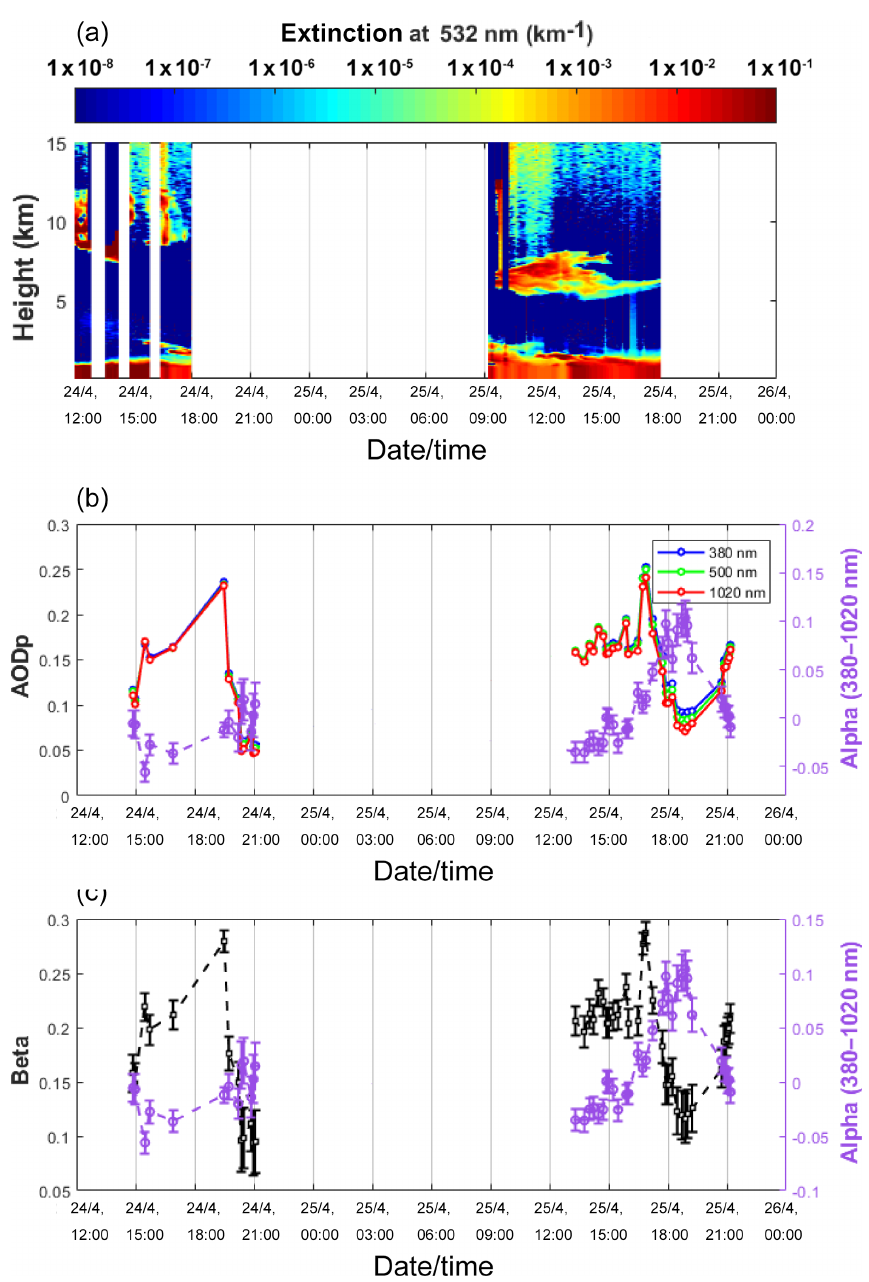
Figure 9. (a) The time evolution of the extinction profile (532nm) obtained from lidar observations at Bariloche between 24 and 25 April 2015. (b) The time evolution of the plume-isolated AOD in the UV–NIR wavelength range versus the Angström exponent (380–1020nm) from sun photometer observations at Bariloche between 24 and 25 April 2015. (c) The time evolution of the Angström turbidity versus the Angström exponent (380–1020nm) from sun photometer observations at Bariloche between 24 and 25 April